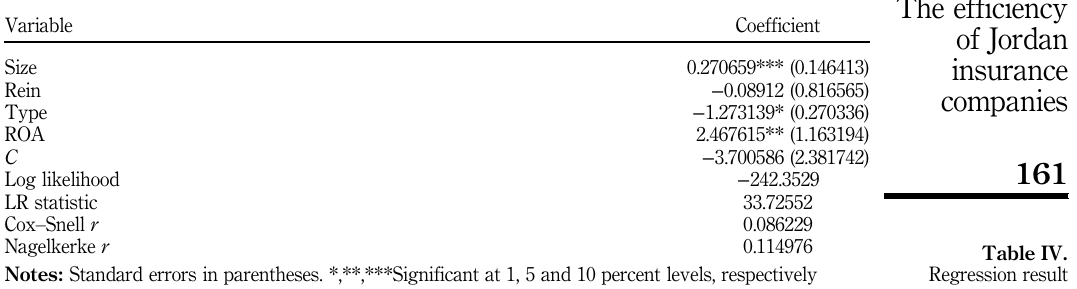
Table IV. Regression